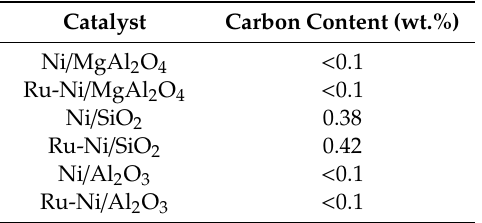
Table 2. Carbon deposits content after the dry reforming process.